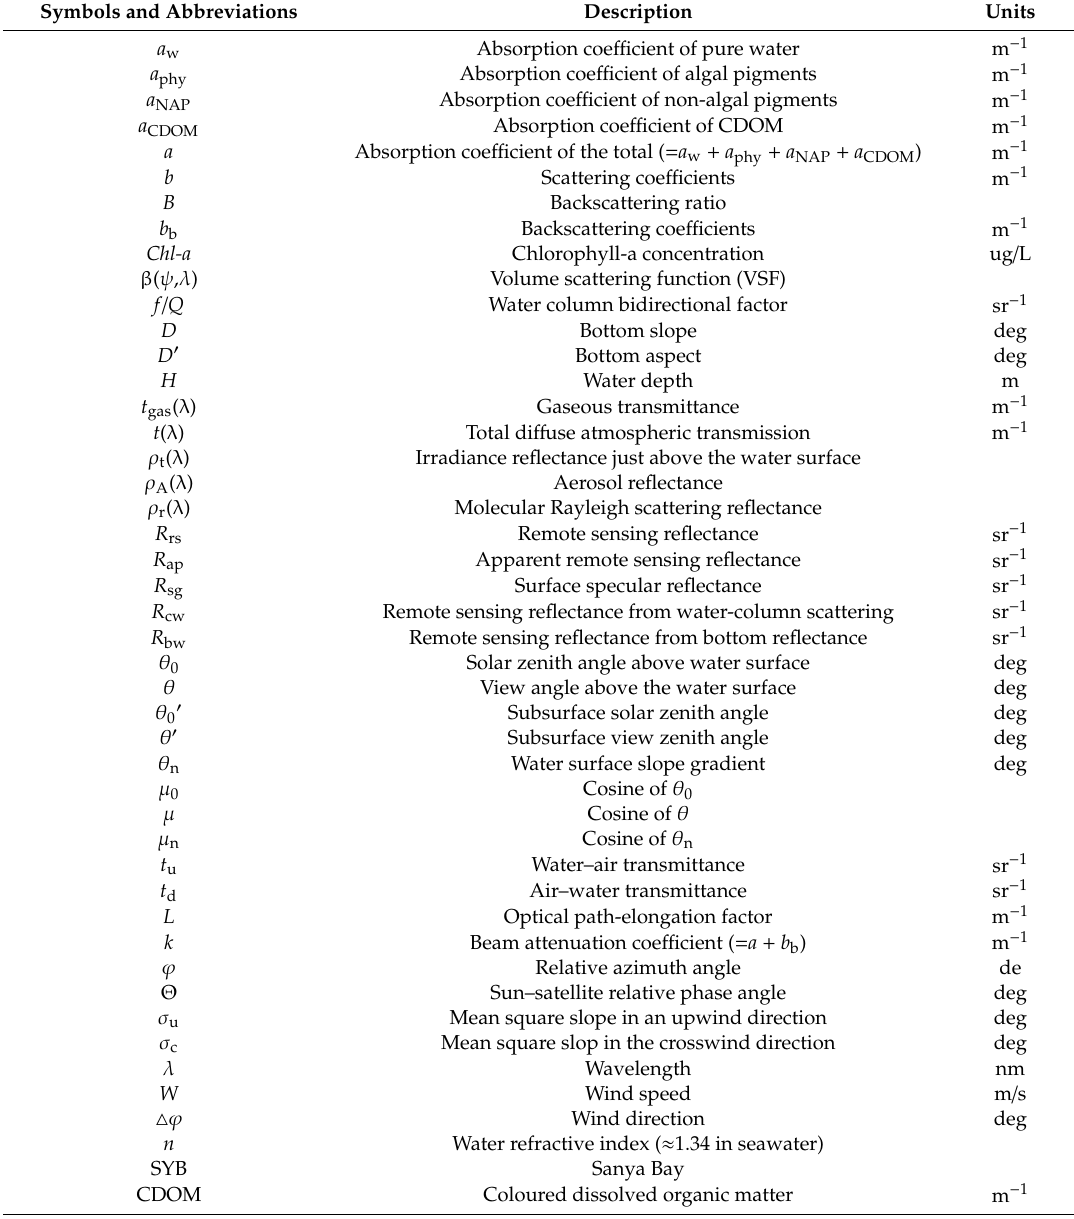
Table 2. The symbols and abbreviations for the parameters used in this